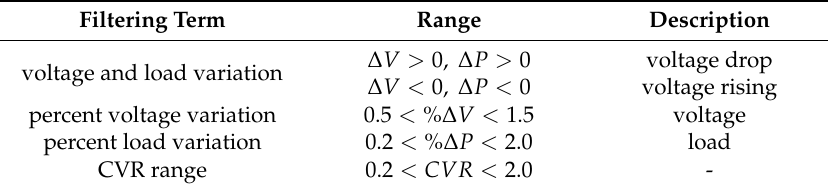
Table 2. Filtering conditions for estimating the load of CVR factors.